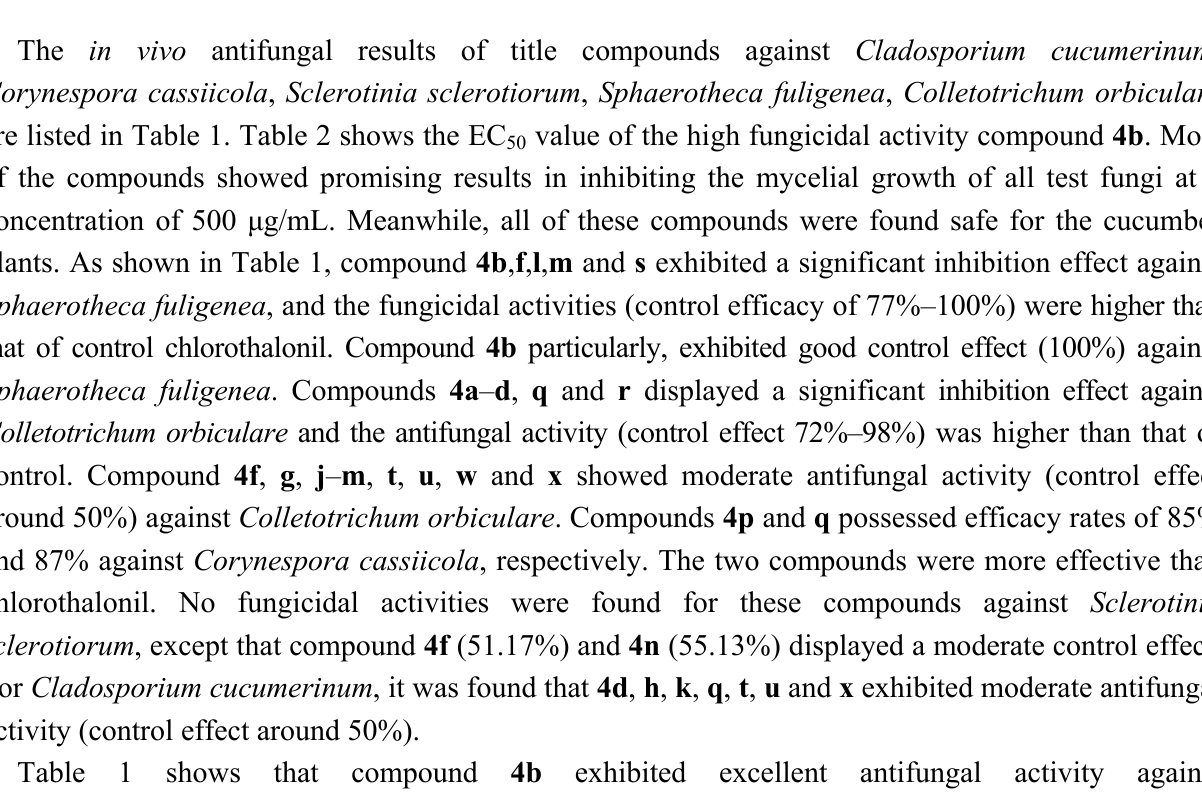
) of 4b was investigated. 50